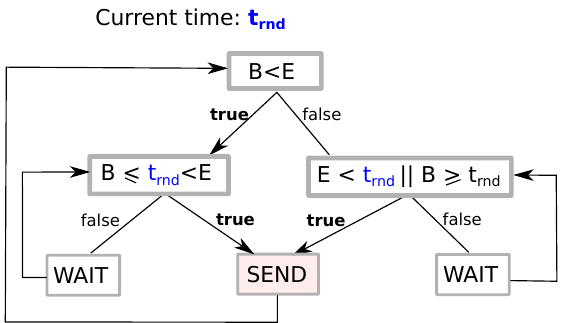
Figure 5. Decision process for queued packets, given B and E , at time t rnd : send or wait? This defines function 1 S ( t rnd ) for any S